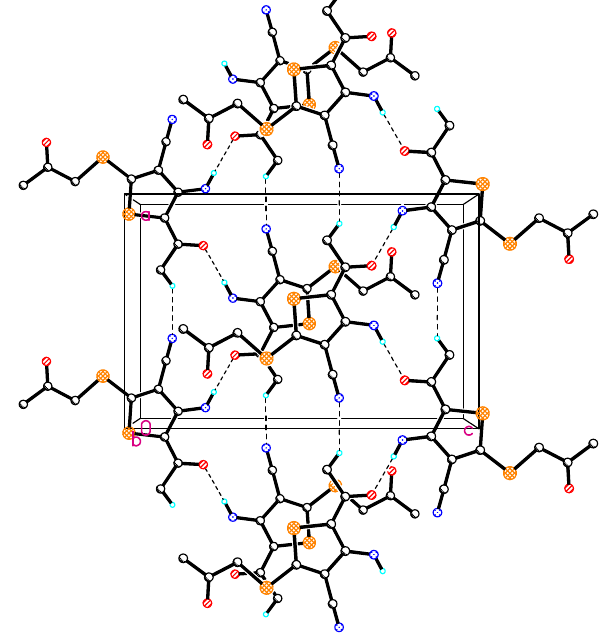
Figure 2. The packing diagram of compound 4 in crystal lattice . Hydrogen atoms not involved in intermolecular hydrogen bonding are omitted for clarity.